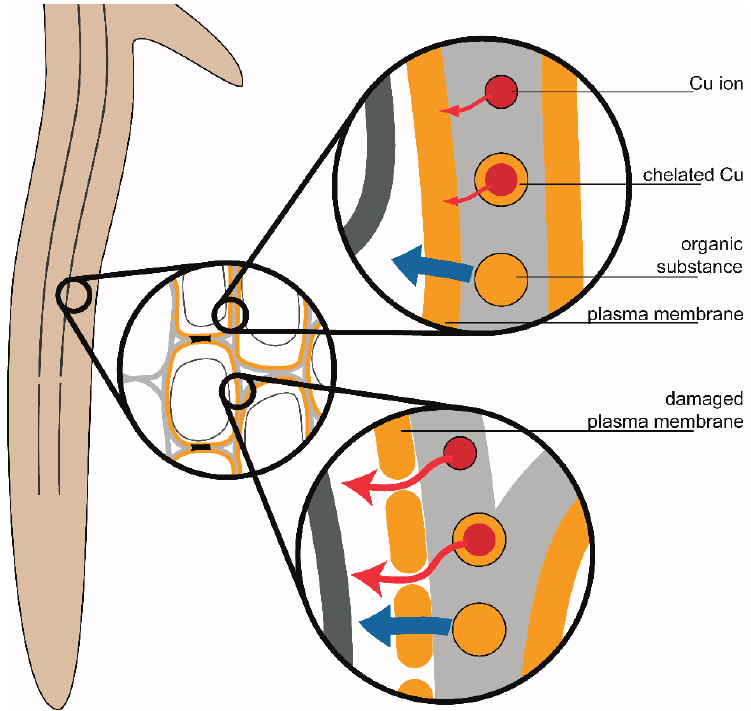
Figure 4. Influence of membrane damage on permeability to ions and organic molecules. Lipophilic partitioning of organic substances occurs through lipid regions, while charged species diffuse slowly through transient aqueous cavities and, in damaged membranes, pores formed due to Cu 2+